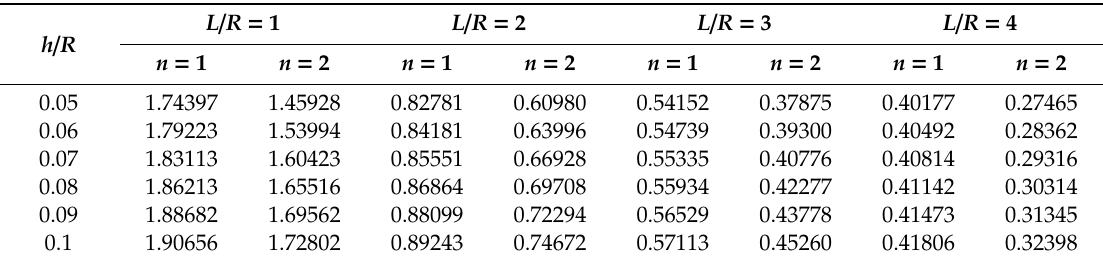
(cid:112) ρ Table 5. Frequency parameters Ω = ω R / E 2 for a three-layered cross-ply [0 ◦ / 90 ◦ / 0 ◦ ] composite laminated cylindrical shell with clamped boundary conditions ( E 2 = 2 GPa, E 1 / E 2 = 25, µ 12 =